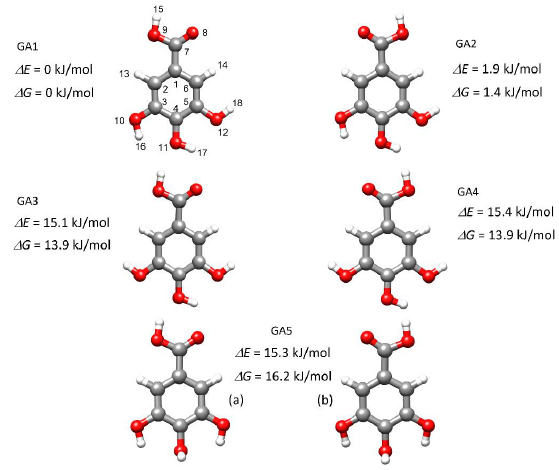
Figure 1. The five stable conformers predicted for GA together with the relative electronic and Gibbs free energies calculated at the B3LYP-D3/6-311++G(2d,p) level. For conformer GA5, the two equiv- alent atropisomers a and b are shown. equivalent atropisomers (a) and (b) are